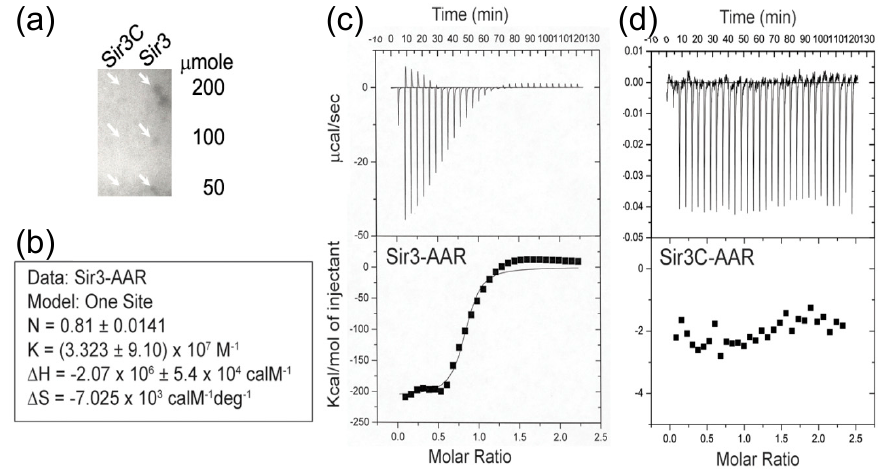
Figure 1. Interaction of O-acetyl-ADP-ribose (AAR) with silent information regulator (Sir)3. ( a ) The dot blotting assay showed the binding of 32 P-AAR to the indicated amount of Sir3 and Sir3C. The white arrows point out the detected individual signal on the dot positions of Sir3 but no signal on the dot positions of Sir3C. ( b ) Summary of the data analysis in the isothermal titration calorimetry (ITC) assay of Sir3-AAR using the MicroCal Origin software package, assuming one set of sites to obtain the binding constant (K), reaction Stoichiometry (N), enthalpy ( ∆ H), and entropy ( ∆ S) with their standard error. ( c – d ) The raw thermograms of ITC data were obtained after each injection (top panels). The integrated curves comprising experimental data points (filled squares) and best fit (curved line) with the one site model are displayed (bottom panels). The interaction between AAR and Sir3 was observed ( c ); however, there was no interaction observed between AAR and Sir3C ( d ).